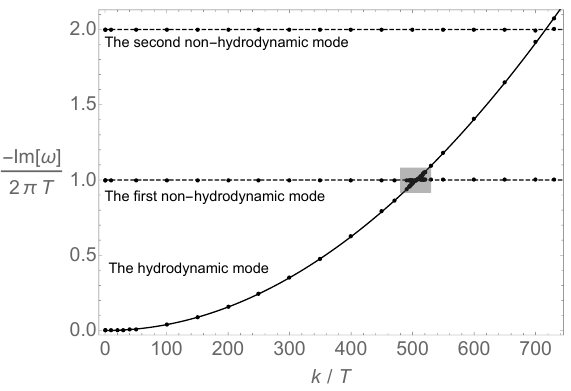
Figure 1 . Quasi-normal modes at m/T = 10 5 . All dots represent quasi-normal modes. The solid line is the hydrodynamic mode (2.7), and the dashed lines are IR modes (3.2). In the gray square region, one can see the collision between the hydrodynamic mode and the first non-hydrodynamic mode.